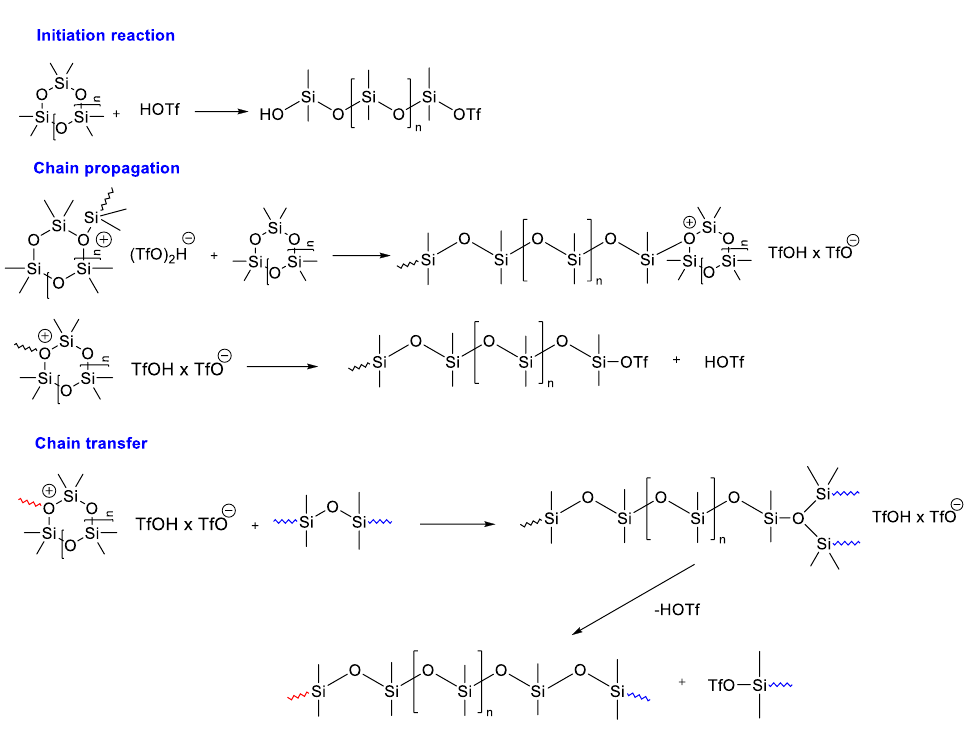
Figure 23. Reaction steps discussed for trifluoromethanesulfonic acid catalyzed polymerization of cyclosiloxanes.